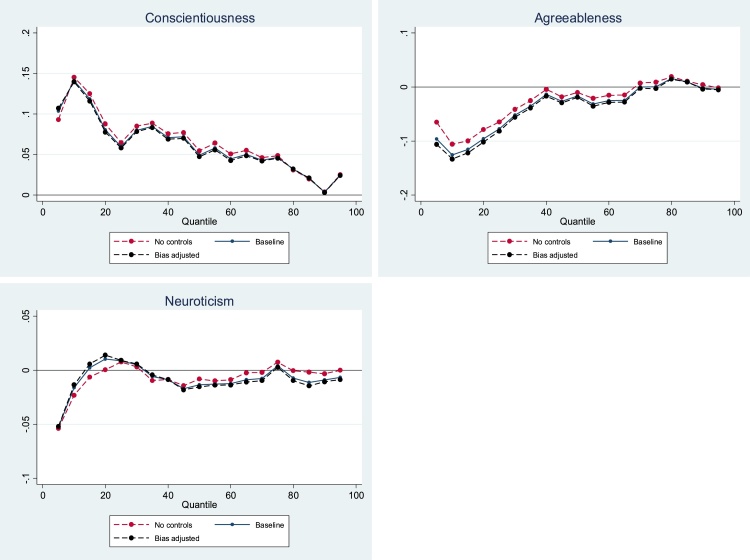
Adolescent non-cognitive skills – cortisol t1-t2 omitted variable bias adjusted relationship.